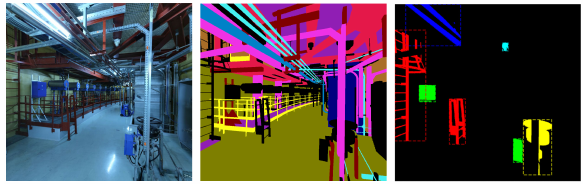
Figure 1. Panoptic segmentation task of an industrial scene. left : original picture. center : stuff objects, colored by class. right : things objects, colored by class.